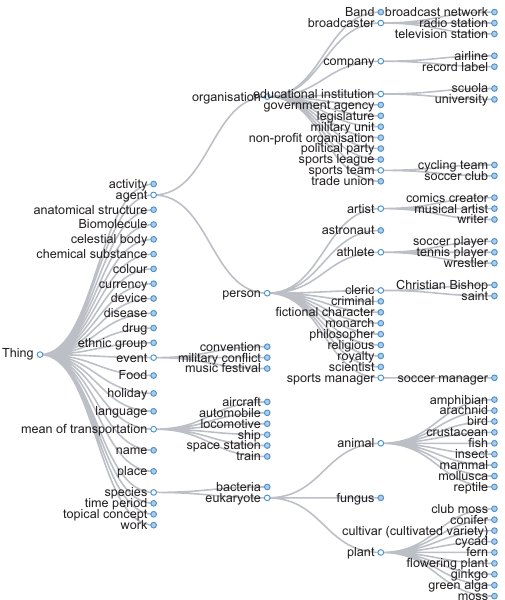
Fig. 1. Hierarchic structure of the generated image database.